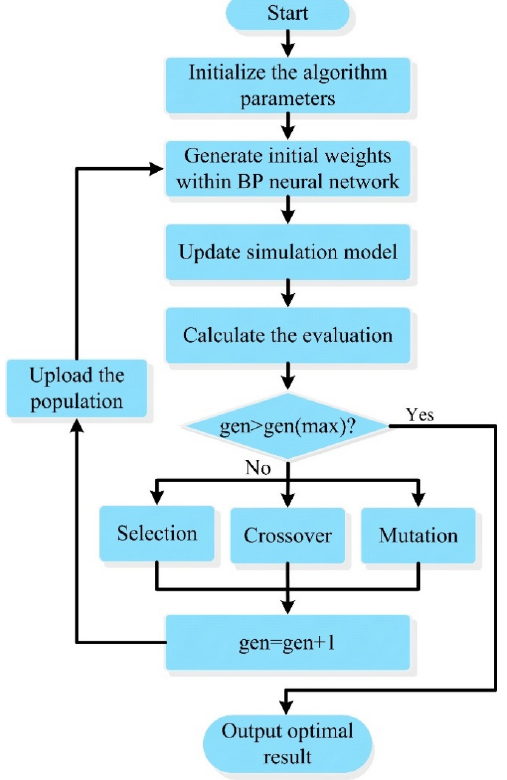
Figure 3. Flow chart of the genetic algorithm program.